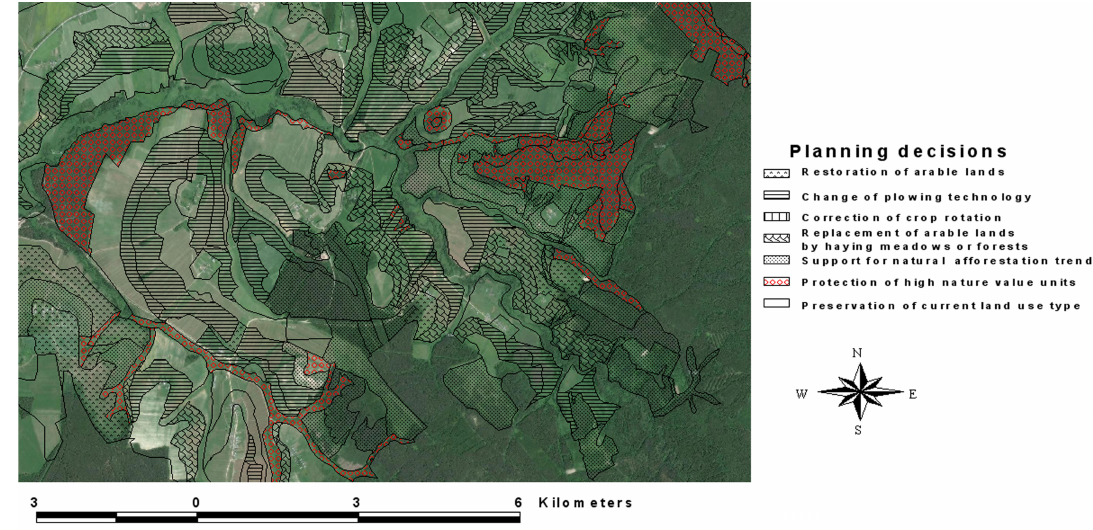
Figure 8. The proposals for landscape planning decisions within the agrolandscape.